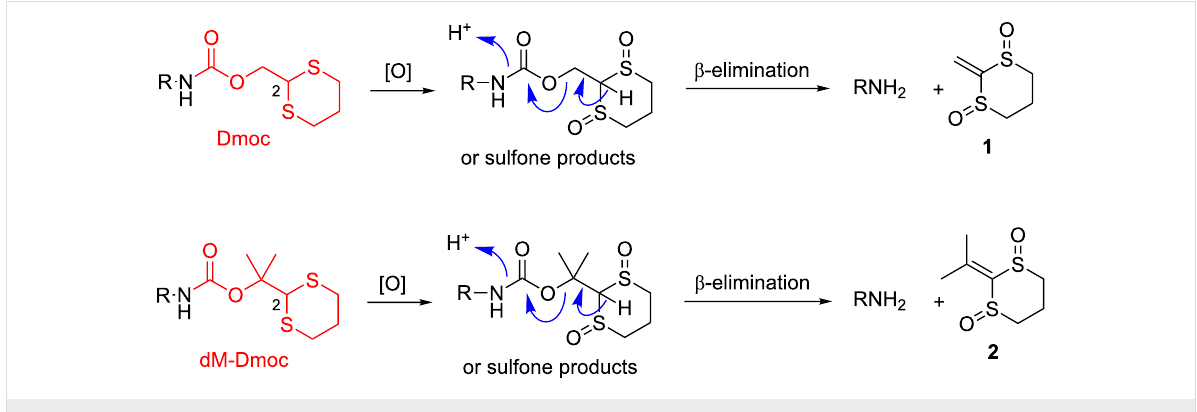
Scheme 1: Dmoc and dM-Dmoc protection and deprotection of